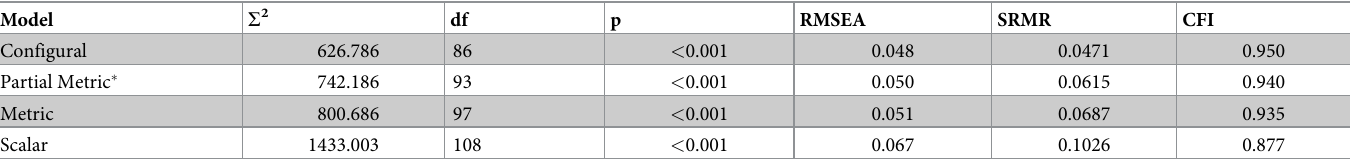
Table 6. Models testing measurement invariance for QUAL and LNT